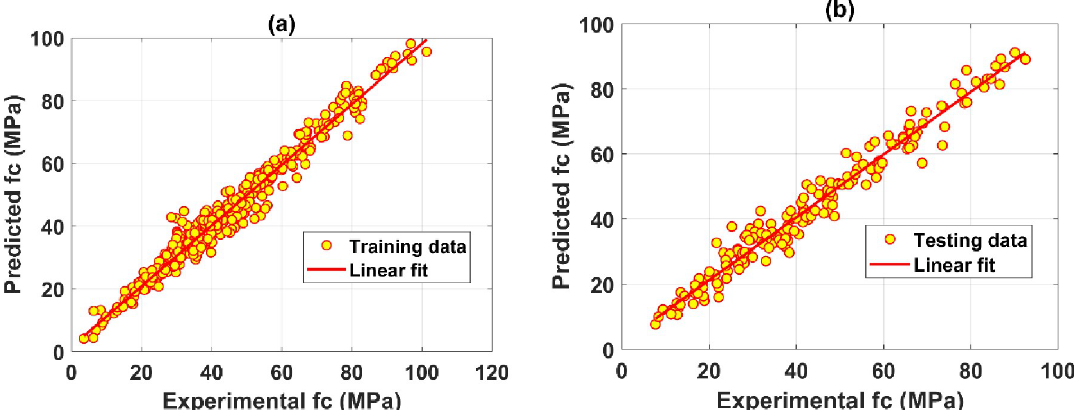
Fig 10. Regression graphs for the case of the best predictor ANN-[9–17–1]: (a) training dataset; (b) testing dataset.